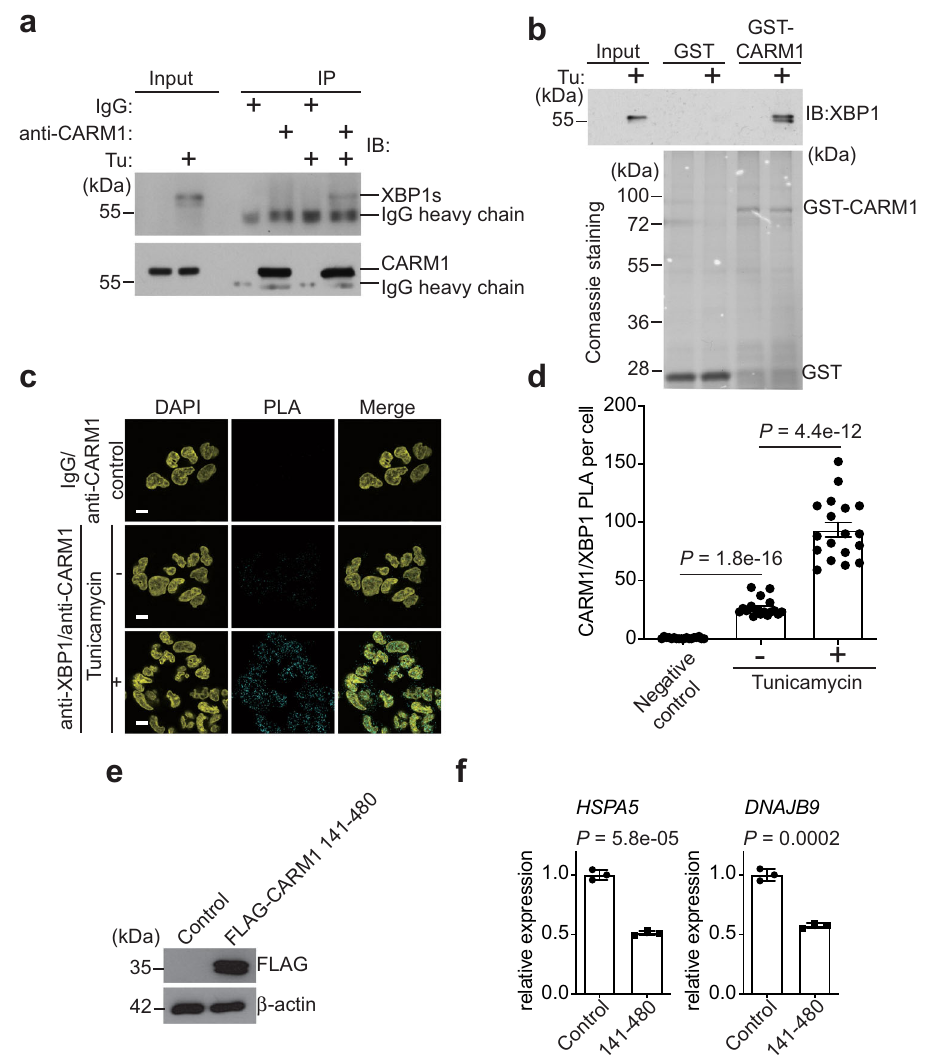
Fig. 4 CARM1 and XBP1s interacts with each other. a Co-immunoprecipitation assay using an anti-CARM1 antibody to detect the interaction between CARM1 and XBP1s in A1847 cells treated with or without tunicamycin (5 μ g/ml, 8 h). Immunoblots are representative of three biologically independent experiments with similar results. b GST-pulldown assay using puri fi ed GST-CARM1 and negative control GST in lysates of A1847 cells treated with vehicle control or tunicamycin (5 μ g/ml, 8 h). Immunoblots are representative of two biologically independent experiments with similar results. c In situ interaction between CARM1 and XBP1s examined by proximity ligation assay (PLA). Isotype-matched IgG and an anti-CARM1 primary antibody were used as negative controls. Scale bar = 10 μ m. d Quanti fi cation of PLA signal in the indicated cells. n = 18. e Expression of FLAG-tagged CARM1 aa 141 – 480 truncation mutant and a loading control β -actin in A1847 cells determined by immunoblot. f RT-qPCR analysis of the expression of HSPA5 and DNAJB9 in the indicated cells. Data represent mean ± SEM, n = 3 biologically independent experiments. P values were calculated using two-tailed t